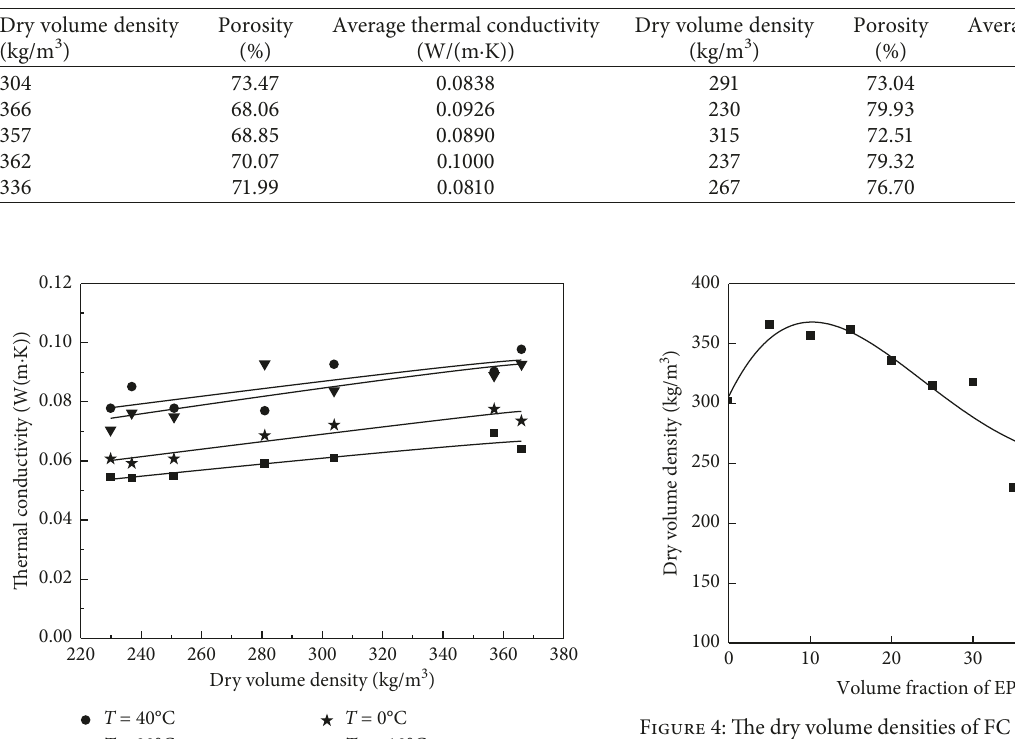
Figure 2: EPS foamed concrete (EFC) specimens: (a) After standing for 24hours at 20 ° C and (b) after 28days under standard curing. Table 5: Dry volume density, porosity, and thermal conductivity of the EFC.